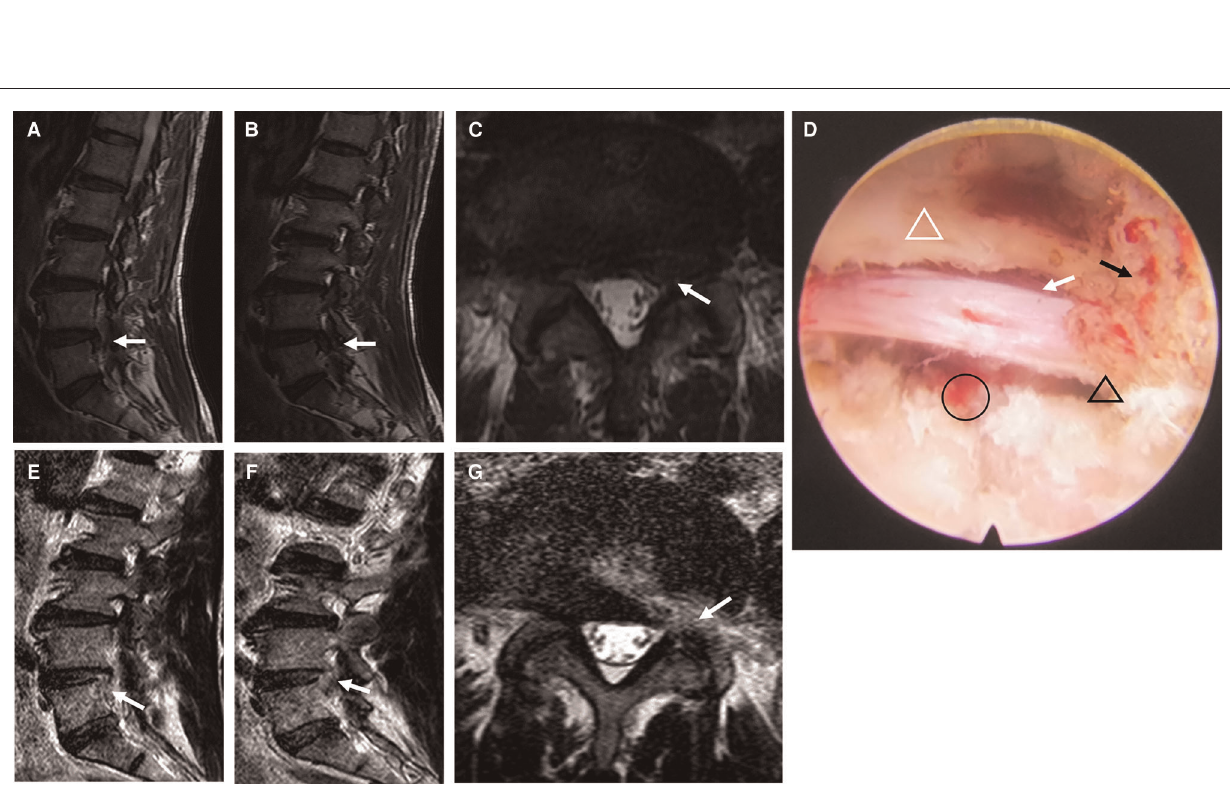
FIGURE 4 | Pre- and postoperative images and intraoperative microscopic images of modi fi ed PETD. ( A – C ) Preoperative MRI demonstrated lumbar disc herniation (white arrows). ( D ) A completely decompressed nerve root is visible endoscopically (white arrow), with removal of the fi brous annulus (black circle), decompression of the lateral recess (black triangle), facet joint resection (black arrow), and partial ligamentum fl avum resection (white triangle). After modi fi ed PETD, ( E,F ), the fi brous ring at the superior margin of the inferior conus was removed, and lateral saphenous fossa decompression was performed ( G ) (white